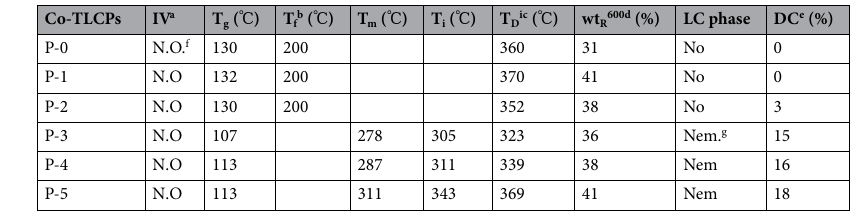
Table 3. General properties of Co-TLCPs. a Inherent viscosity was measured at a concentration of 0.1 g/ dL solution in a phenol/p-chloro-phenol/TCE = 25/40/35 (w/w/w) at 25 °C. b Flow temperature observed by polarized optical micrographs. c At a 2% initial weight-loss temperature. d Weight percentage of residue at 600 °C. e Degree of crystallinity. f Not observed. g